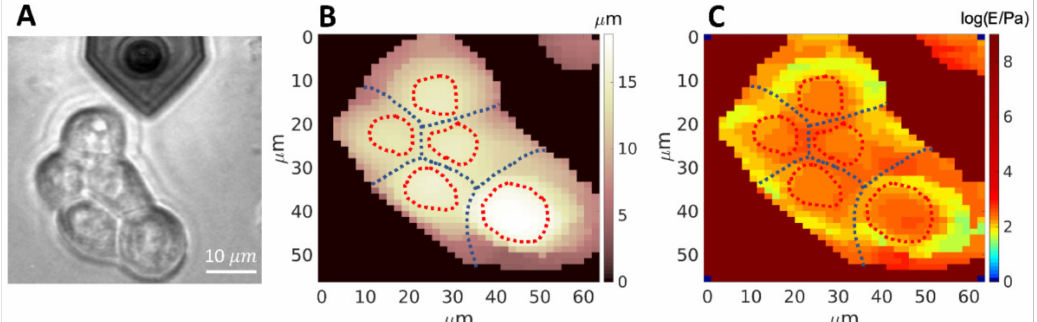
Figure 6. Representative images for the combined topographical and mechanical analysis of cell clusters. Optical image of a cell cluster from the RT112 cell line ( A ); topographic map ( B ), and Young’s modulus map ( C ) in logarithmic scale, of the same cluster shown in ( A